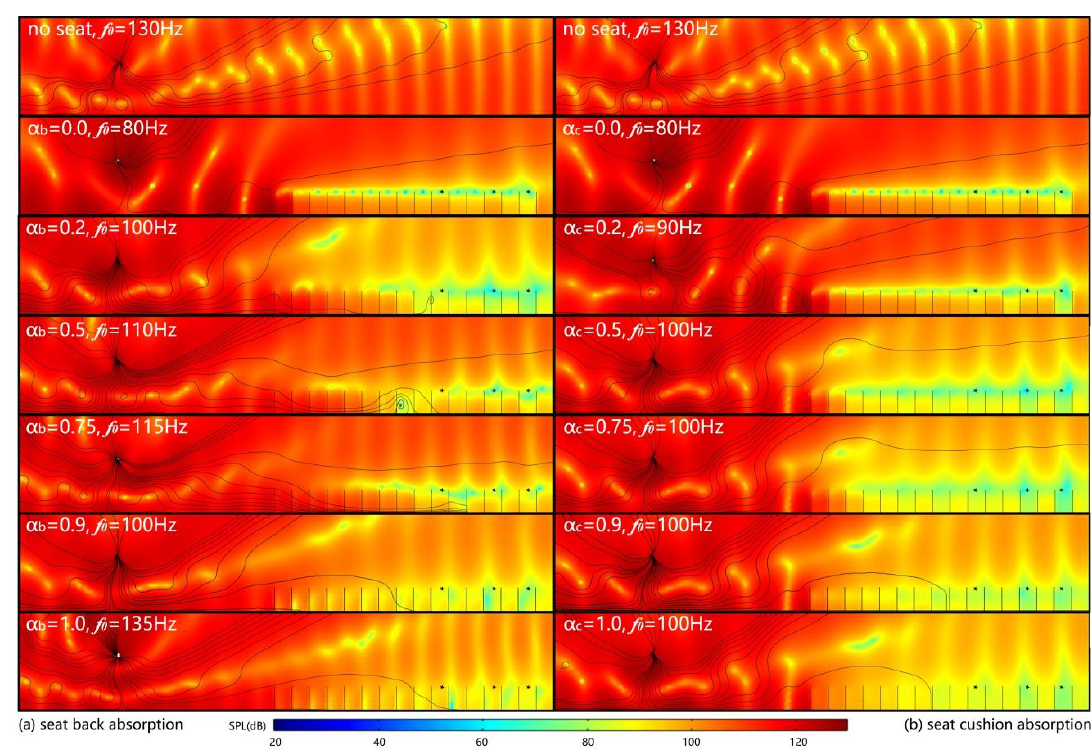
Figure 5. Comparison of SPL distributions at corresponding different dip frequencies with different sound absorption coefficients of seat backs ( a ): no seat; α b = 0 .0; α b = 0.2; α b = 0. 5; α b = 0 .75; α b = 0.9; α b = 1.0; and of seat cushions ( b ): no seat; α c = 0 .0; α c = 0.2; α c = 0. 5; α c = 0 .75; α b = 0.9; α c = 1.0.